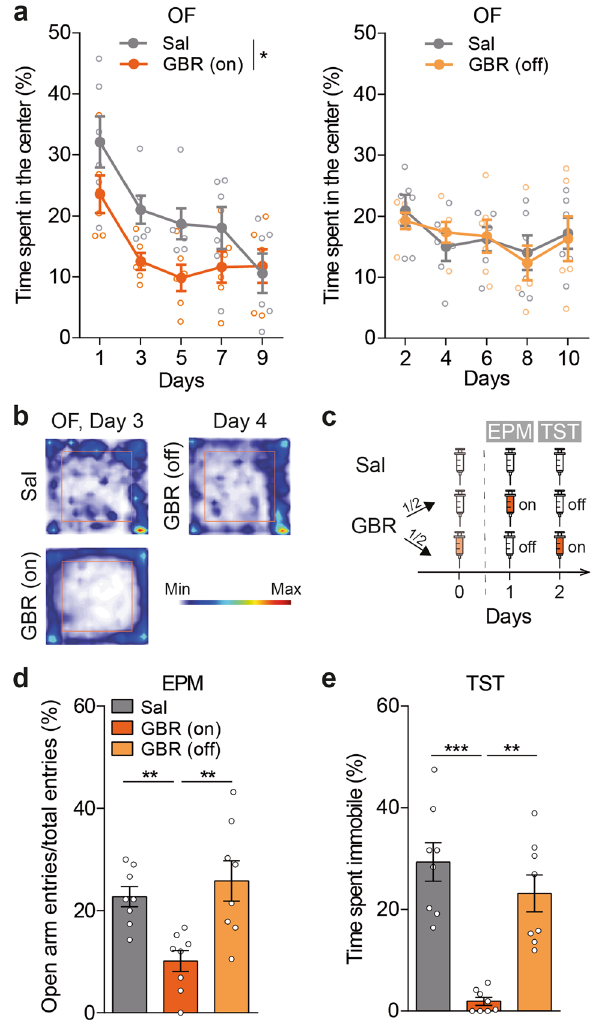
Figure 2. Anxiety-like behaviors co-existed with anti-depressant-like phenotype in GBR-treated mice. ( a ) GBR-treated mice spent less time in the OF center compared to Sal-treated mice during the “on” days (left, Two-way repeated measures ANOVA, group: F (1,10) = 5.61, *p = 0.039, days: F (4,40) = 13.89, p < 0.001, interaction : F (4,40) = 1.54, p = 0.209, n = 6), but not during the “off” days (right, two-way repeated measures ANOVA, group: F (1,10) = 0.01, p = 0.911, days: F (4,40) = 3.07, p = 0.027, interaction : F (4,40) = 0.38, p = 0.821, n = 6). ( b ) Representative heatmaps of the mean position in the OF of Sal and GBR (on) animals (day 3) and GBR (off) animal (day 4). The orange squares delimit the center of the arena. ( c ) Scheme of the injection protocol to behaviorally test GBR (on) and (off) animals in the Elevated Plus Maze test (EPM) and Tail Suspension Test (TST). ( d ) In the EPM, GBR (on) mice showed less entries in the open arms/total entries, relative to Sal and GBR (off) mice (one-way ANOVA, F (2,21) = 8.78, p = 0.002 followed by Holm–Sidak post-hoc test, **p < 0.01, n = 8). ( e ) GBR (on) mice spent less time immobile in the TST, compared to Sal and GBR (off) mice (Kruskal–Wallis test, H = 16.24, p < 0.001, Dunn post-hoc analysis, **p < 0.01, ***p < 0.001, n = 8). Data are shown as mean ± SEM and individual data